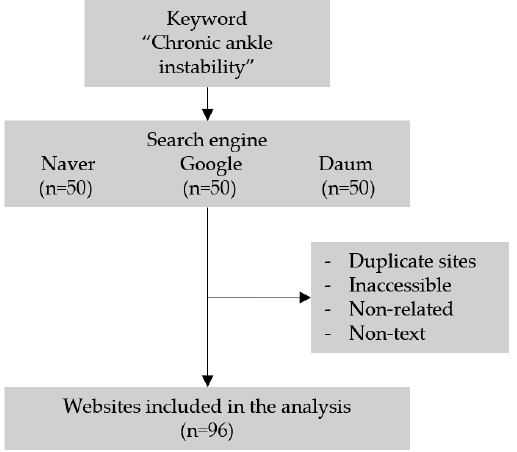
Figure 1. Method of selection and evaluation of websites.